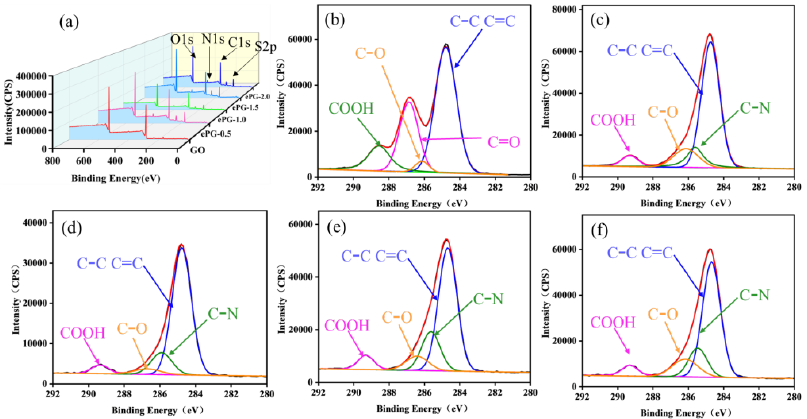
Figure 3. XPS spectra of ( a ) GO, ePG 0.5-2; and C1s peak-fitting curves of ( b ) GO, ( c ) ePG-0.5, ( d ) ePG-1, ( e ) ePG-1.5 and ( f ) ePG-2. Table 1. Contents of different elements of GO and ePG.